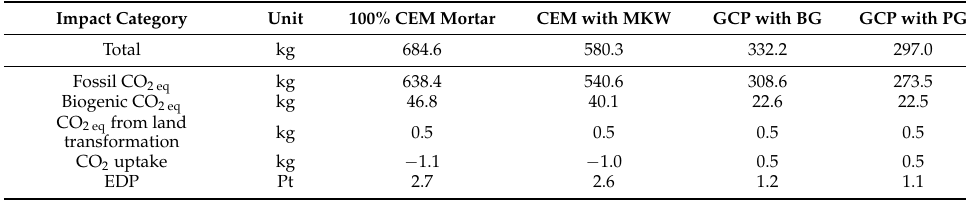
Table 2. Total CO 2 released during the production of 1 m 3 of